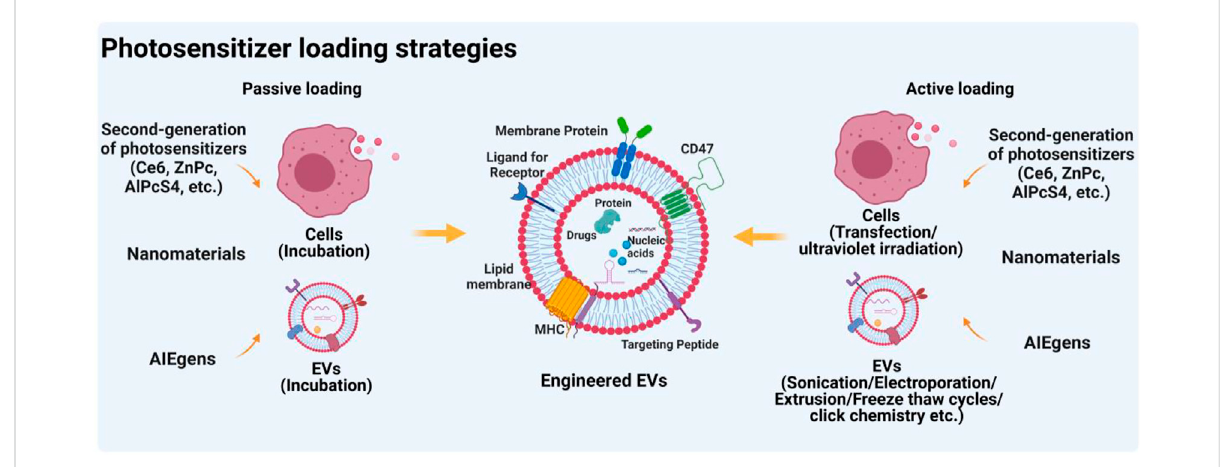
FIGURE 2 Strategies for loading photosensitizers into EVs. Figure was prepared with BioRender ®